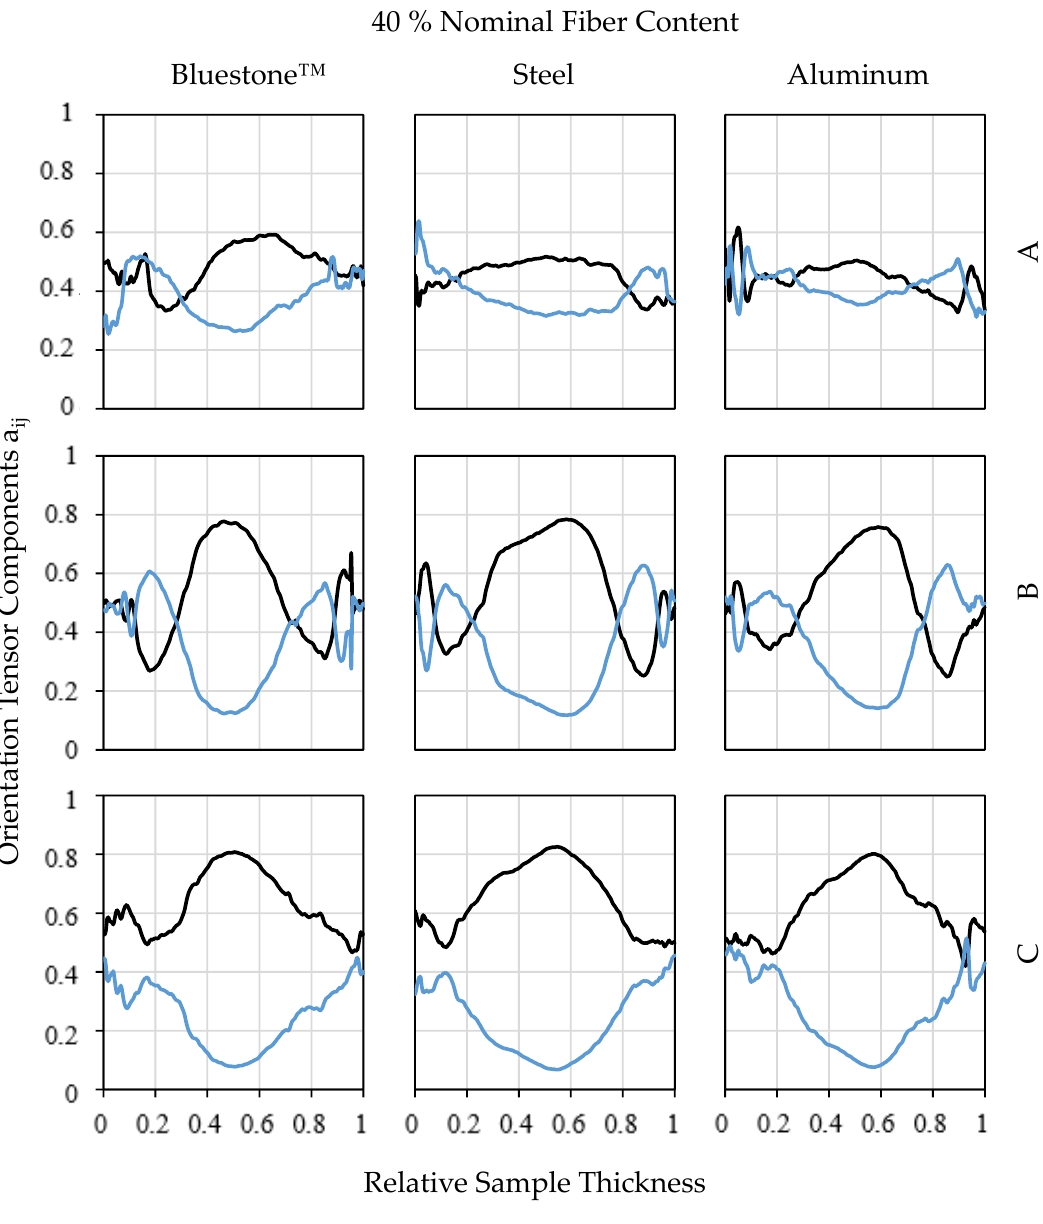
Figure A3. Orientation tensor components ( a 11 , a 22 ; without a 33 for better overview) and relative sample thickness for a nominal fiber content of 40 wt.%. Specimens were created with Bluestone, steel, and aluminum tools, with samples from regions A, B, and C (in accordance with Figure 9).